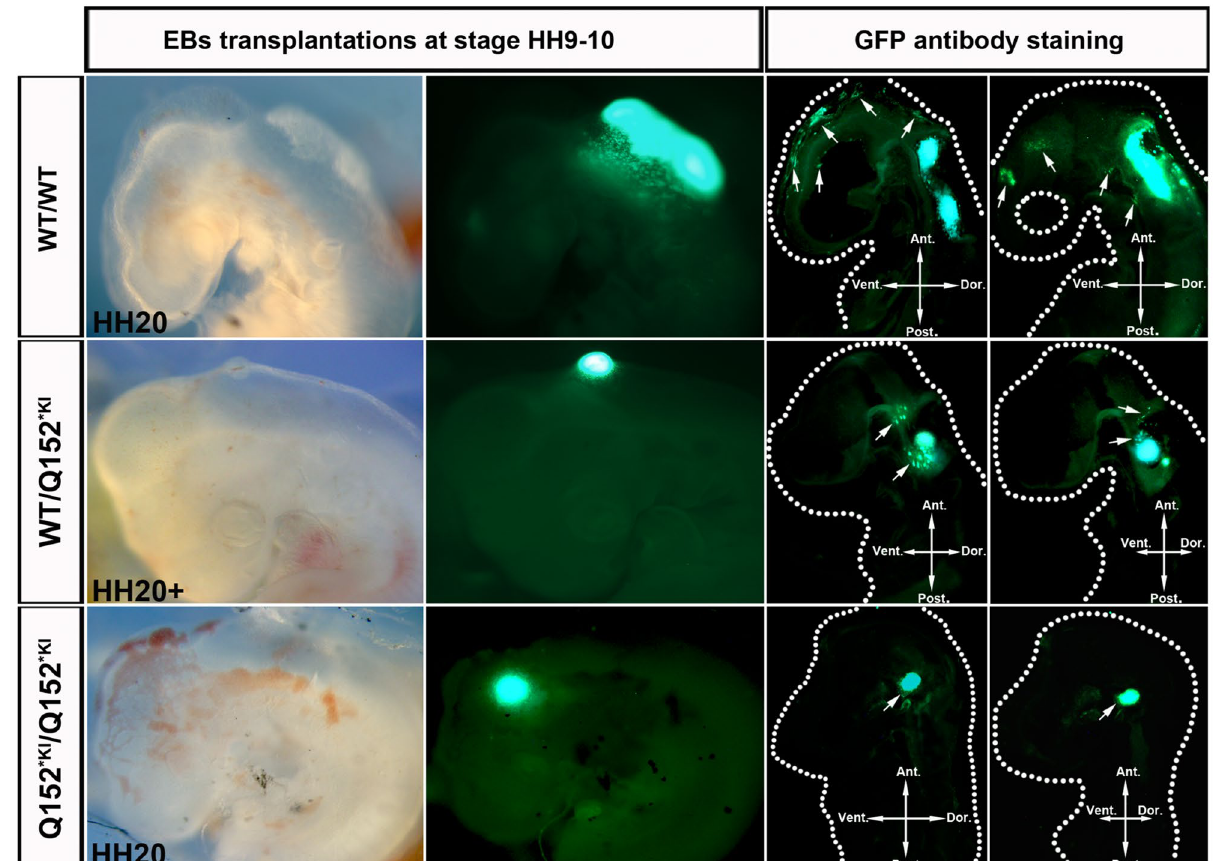
Figure 5. Absent migration of xenotransplanted MAPRE2 deficient neural crest progenitors in chicken embryos. Representative whole mount bright field and fluorescent images of chicken embryos at development stage HH 20 with corresponding sagittal sections. Embryos have been transplanted with EBs at day 5 of neural crest differentiation 49 , generated from EmGFP tagged MAPRE2 deficient iPSCs. Sagittal sections have been stained against endogenous EmGFP. WT/WT cells are observed migrating into the branchial arches and facial mesenchyme on whole mount and in sections, indicated by white arrows. Q152* KI /WT cells emerge from the EB but fail to migrate away towards the branchial arches and facial mesenchyme (indicated by white arrows). Complete MAPRE2 knock out cells (Q152* KI /Q152* KI ) fail to emerge from the EB and migrate. ( Ant. anterior, Vent. ventral, Dor. dorsal, Post.